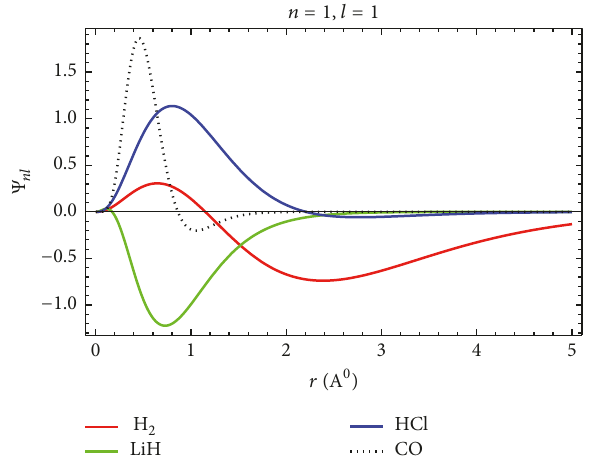
Figure 4: Wave function plot for the interaction potential with orbital angular quantum number 𝑙 = 1